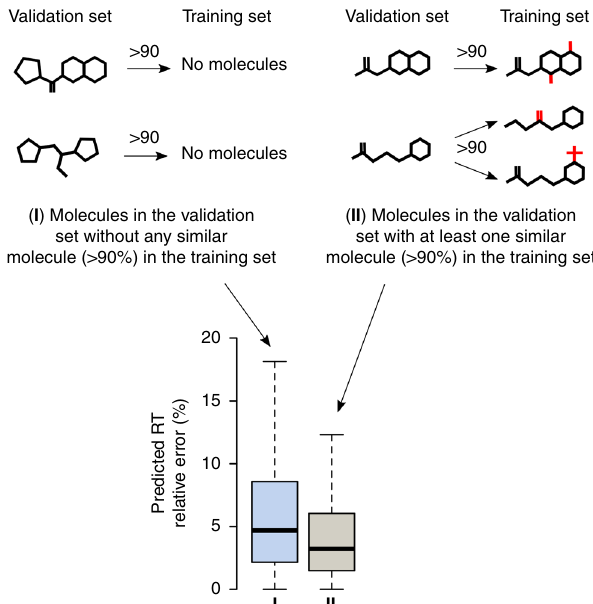
Fig. 3 Prediction performance dependency on the training set. The prediction error depends on the number and similarity level of molecules in the training set. To assess this dependency, the predicted RT error of molecules in the validation set having at least one similar molecule in the training set (more than 90 % of similarity) was compared to molecules in the validation set with no similar molecule in the training set. Box plots represent median value and interquartile range (25 – 75 % percentiles) excluding